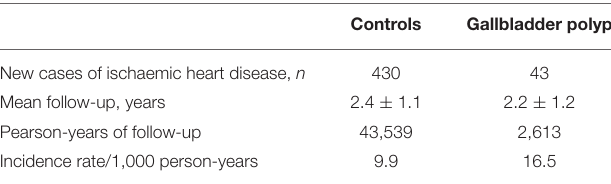
TABLE 2 | Overall incidence of ischaemic heart disease according to the presence of gallbladder polyp.